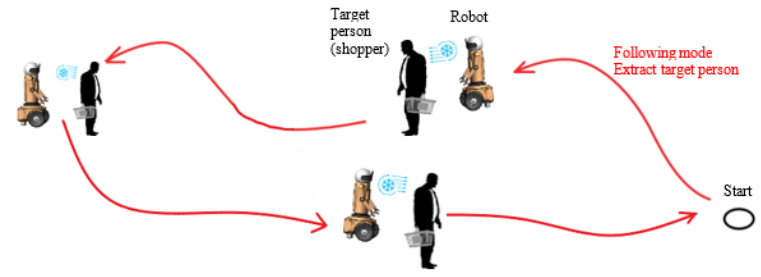
Figure 2. Robot tracking a target person and moderating the